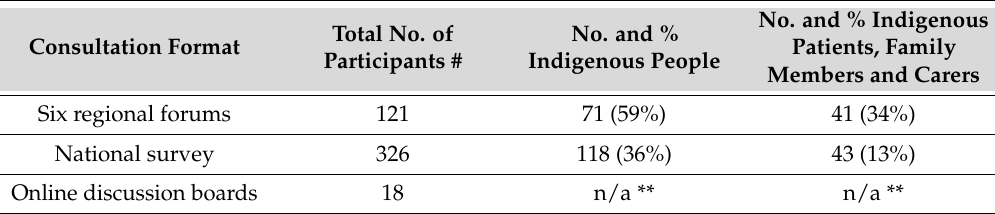
Table 2. Numbers of participants in stakeholder